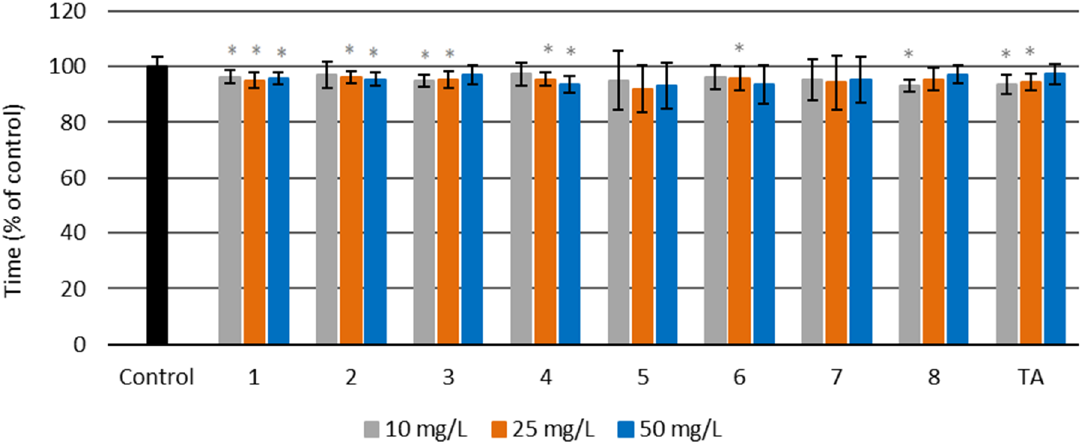
Figure 8. Prothrombin time (PT) for amides 1–8 and tranexamic acid (TA) at three different concentrations—10, 25, and 50 mg/L—and for the control sample of human blood plasma (un- concentrations — 10, 25, and 50 mg/L — and for the control sample of human blood plasma treated with the examined amides) ( * p < (untreated with the examined amides) ( * p < 0.05).